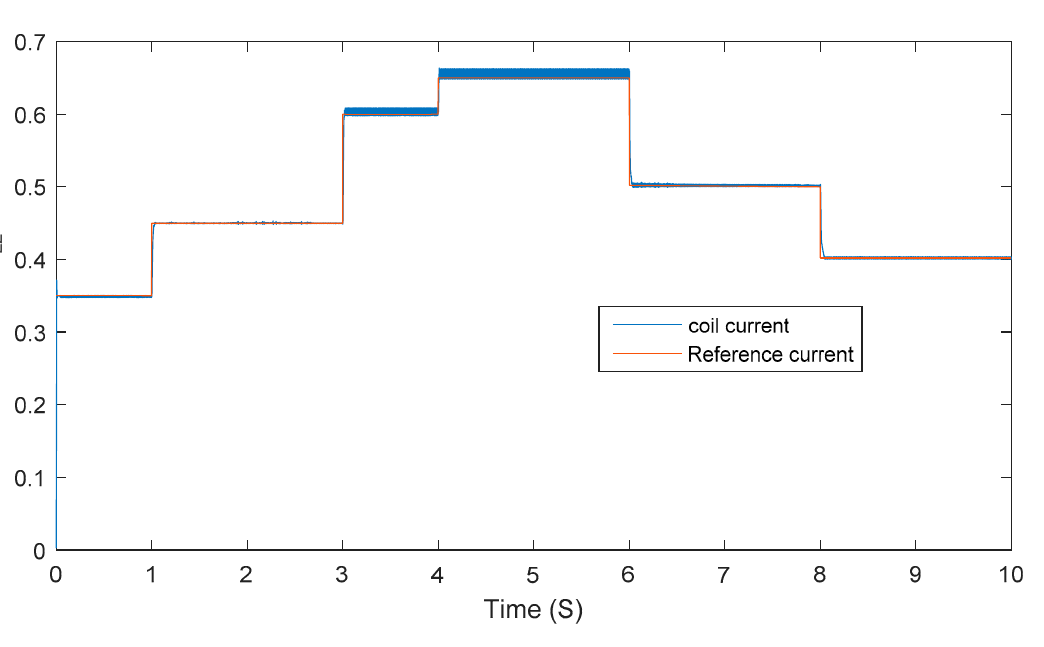
Figure 11. Current through 2nd coil and its reference.